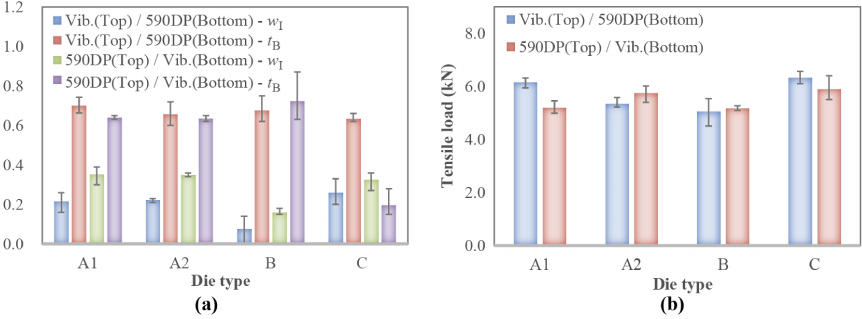
Figure 6. ( a ) w I and t B and ( b ) the tensile shear loads for self-piercing riveted joint between vibration- damping steel and SPFC590DP or 590DP with respect to the die types.